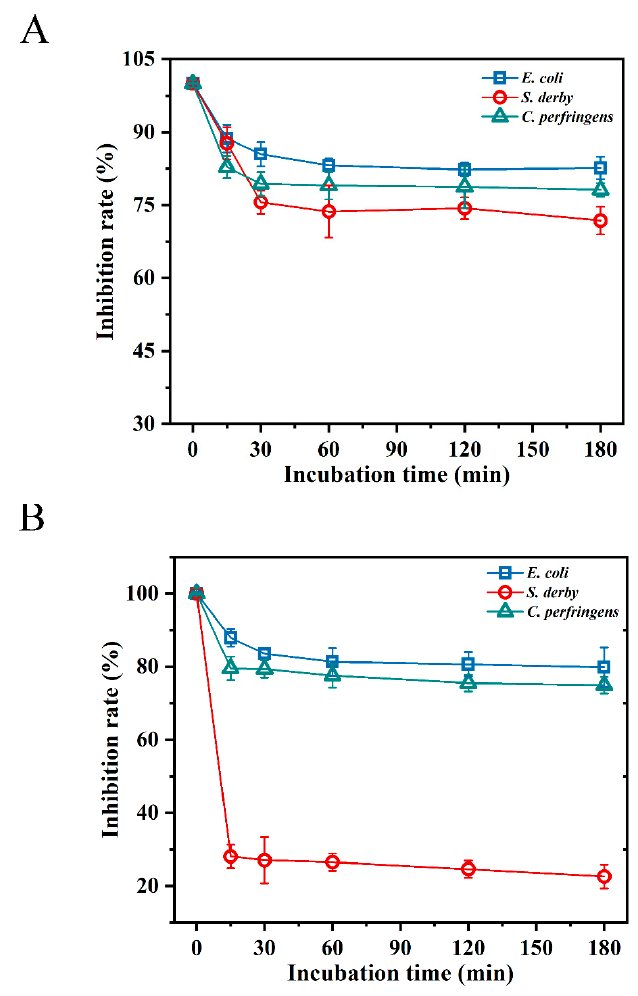
Figure 2. Effect of digestive enzymes on the antimicrobial activity of BMGlv2 against E. coli ATCC 25922, S. derby ATCC 13076, and C. perfringens CVCC 2032. ( A ) The effect of pepsin on the antimicro- bial activity of BMGlv2. ( B ) Effect of trypsin on the antimicrobial activity of BMGlv2. Results were given as the mean ±